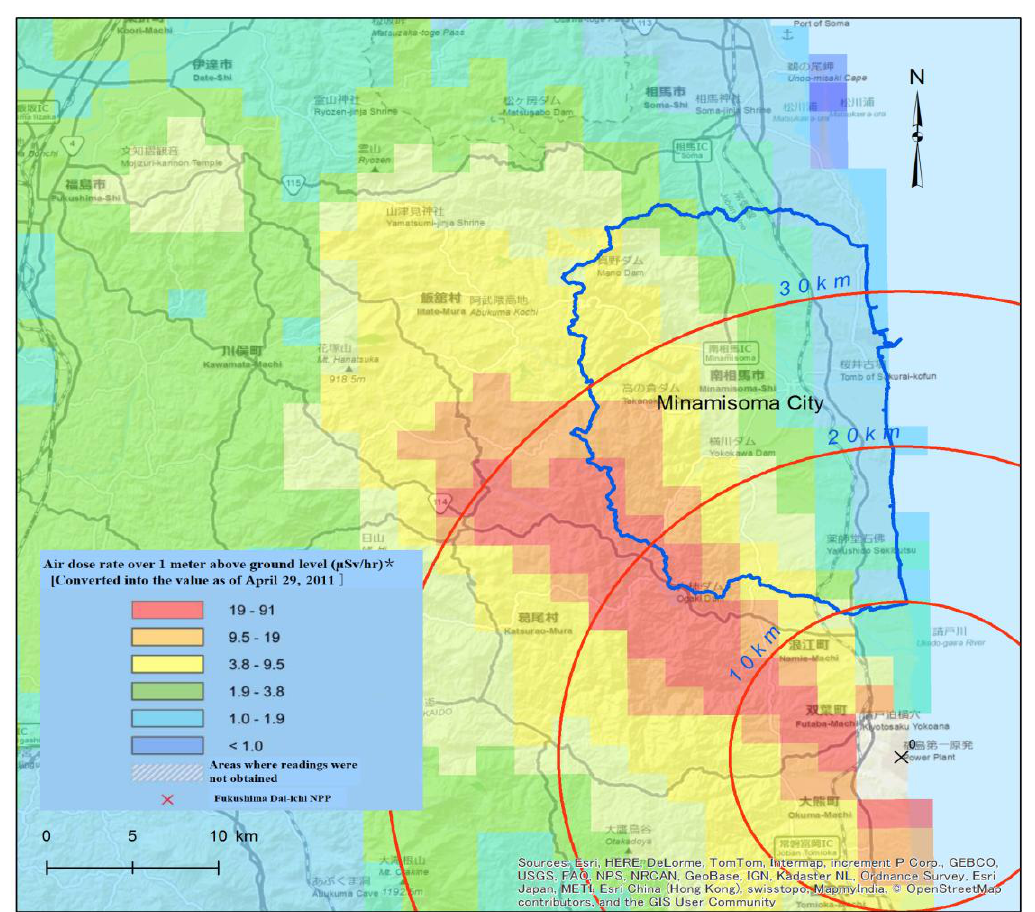
Figure 1. Exclusive Radiation Zones around FDNPP and Location of Study Area